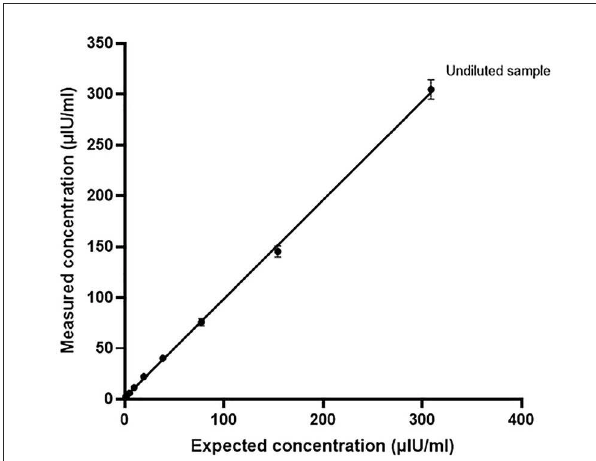
FIGURE2 Recovery upon dilution (RUD) of nonhuman serum-based insulin control solutions with Immulite ® 1000 CLIA. The RUD was calculated as a percentage of recovery of the insulin concentration in the two-fold serially diluted samples with the corresponding expected concentrations. Samples were diluted with commercially available insulin diluent buffer. FIGURE3